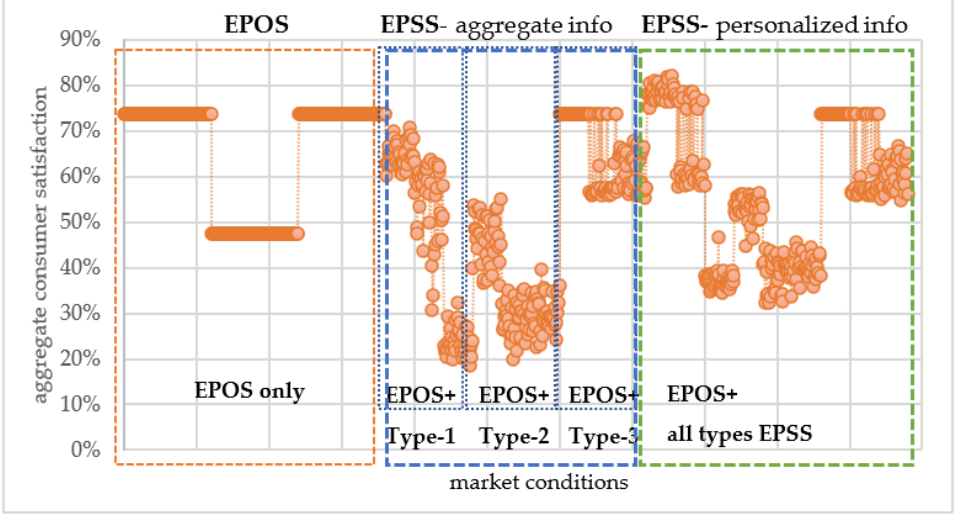
Figure 4. Market conditions’ effect on aggregate consumer satisfaction. (Data can be found in the Supplementary